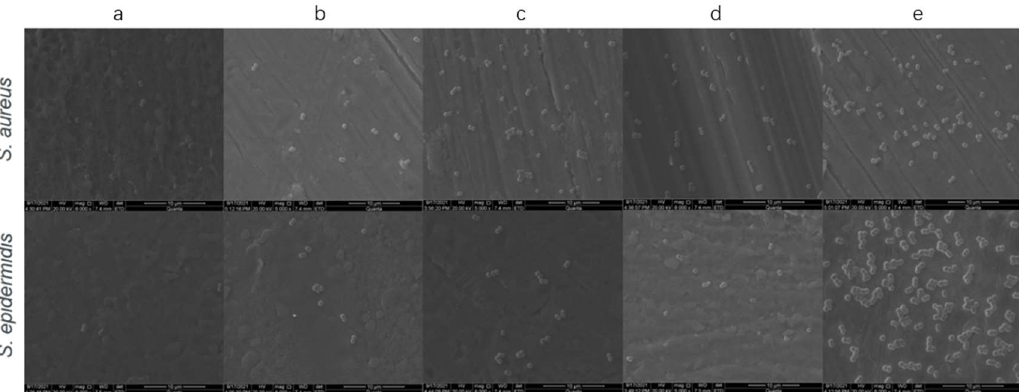
Figure 7. SEM images of S. aureus and S. epidermidis colonies on samples with different coatings after 6 h incubation. Notes: ( a ) groove pattern; ( b ) micro-hole pattern; ( c ) directional grain pattern; ( d ) stripe pattern ( e ) control group. Abbreviations: SEM, scanning electron microscopy.